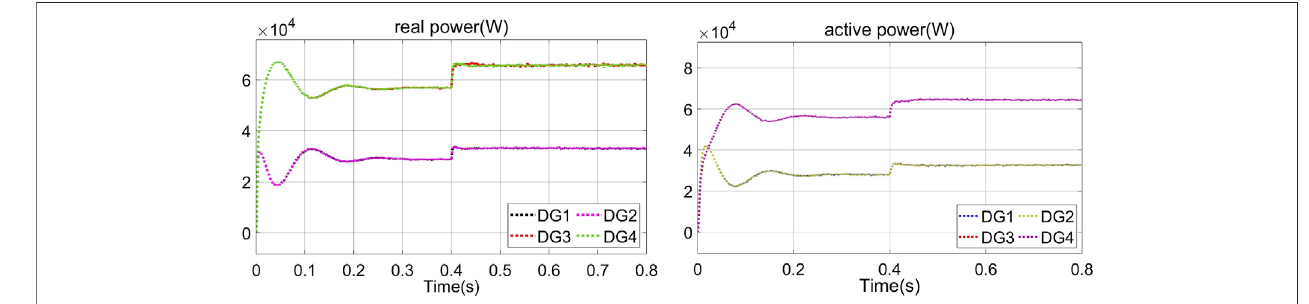
FIGURE 7 | power sharing of DGs.